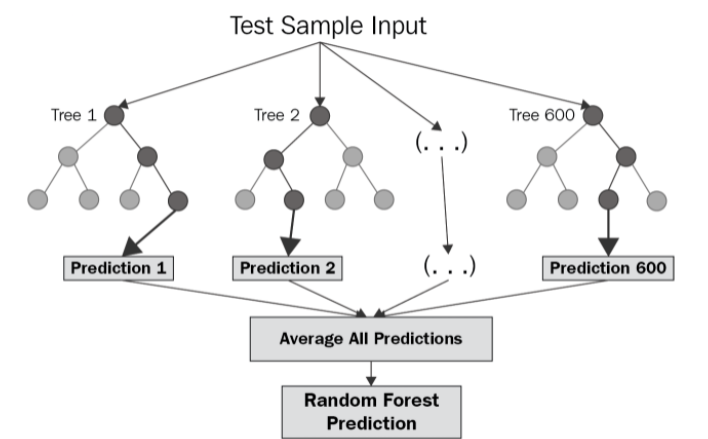
Figure 2. The structure of random forest. The decision trees run in parallel with no interaction among them. A random forest operates by constructing several decision trees during training time and outputting the mean of the classes as the prediction of all the